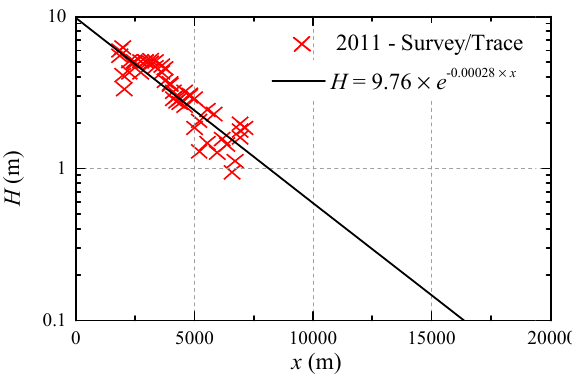
Figure 7 indicates an example of tsunami height damping in the Natori River during the 2011 Tohoku Tsunami. From the slope of the regression line, they obtained the damping coefficient for rivers in Miyagi Prefecture.